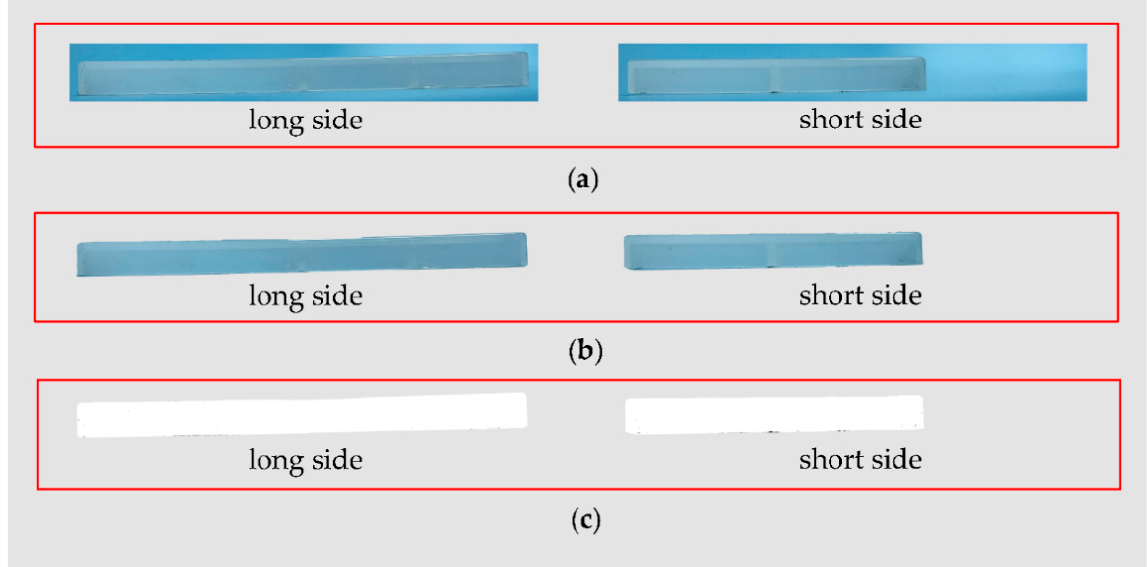
Figure 4. Images of the main steps during the image processing of a part molded by EGAIM: ( a ) photographed images; ( b ) part images without background; ( c ) binary images.